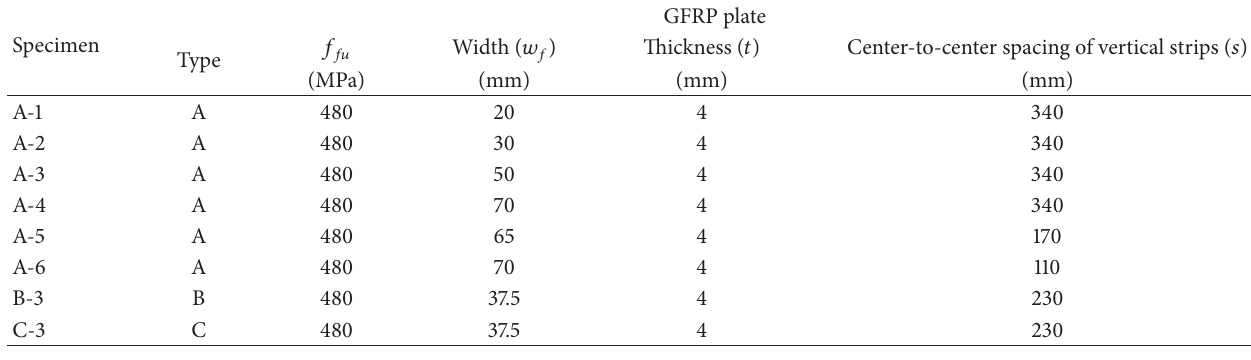
Table 1: Details of the experimental variations of the GFRP plate designs.